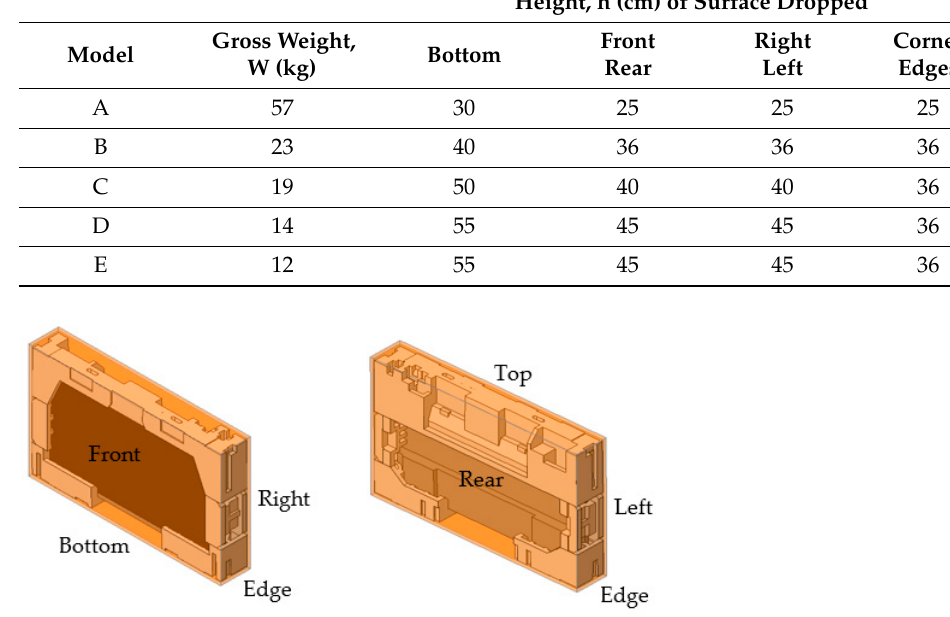
Figure 4. View of package surfaces.